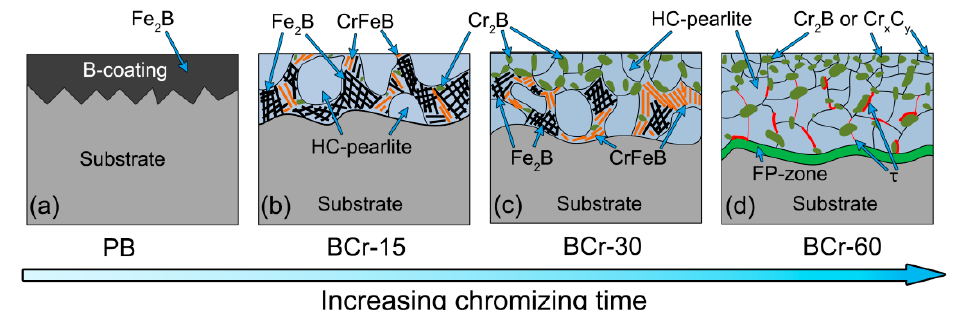
Figure 9. Sketch maps showing the microstructure evolution via the increasing chromizing time: ( a ) pre-boronizing; ( b ) ( c ) ( d ) chromizing for 15, 30, and 60 min,